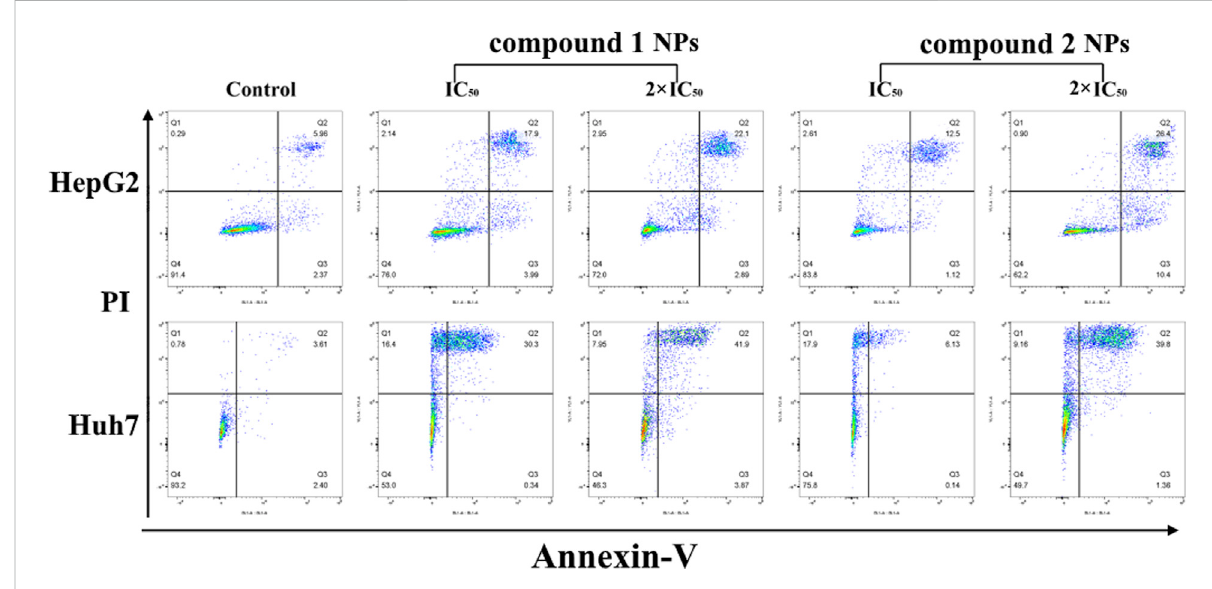
FIGURE 5 Flow cytometry results of compounds 1 and 2 NPs on HepG2 and Huh7 under different concentrations.